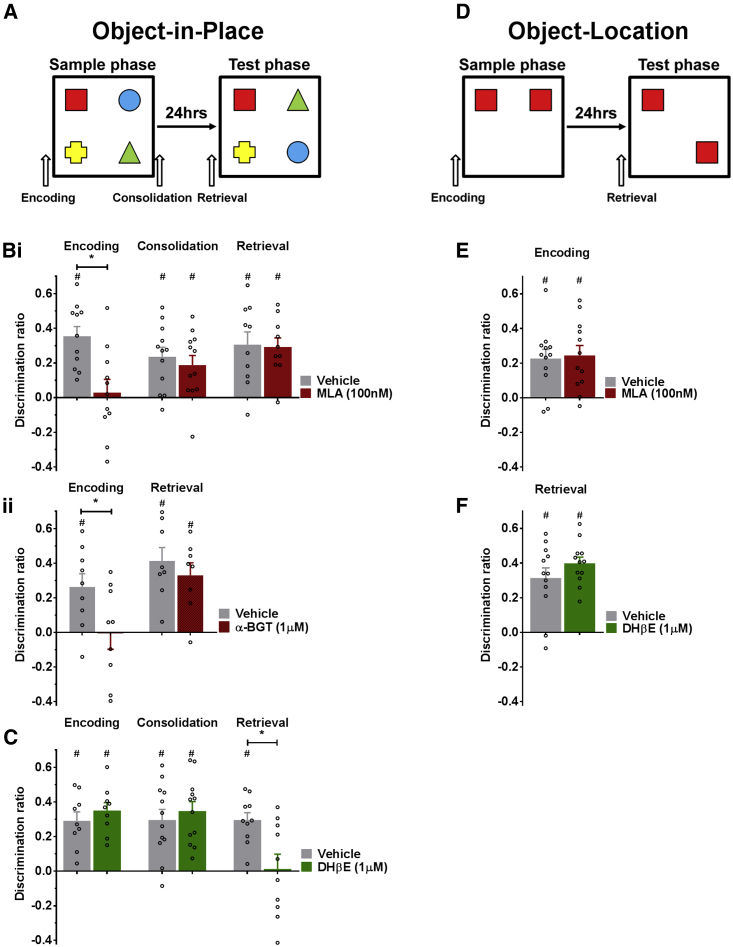
Associative Recognition Memory Is Dependent on Activation of Different nAChRs in the mPFC(A) Schematic of OiP task. Arrows represent the timing of mPFC infusions.(B) MLA impaired OiP memory when infused before the sample phase (encoding; n = 11), but not after the sample phase (consolidation; n = 12) or before the test phase (retrieval; n = 10) (i). α-BGT also impaired discrimination when infused before the sample phase (n = 9), but not before the test phase (n = 8) (ii).(C) DHβE impaired OiP memory if given before the test phase (n = 10), but not before (n = 9) or after (n = 12) the sample phase.(D) Schematic of the OL task(E and F) OL memory was not impaired by MLA infusion before the sample phase (n = 12) (E) or DHβE infusion before the test phase (n = 12) (F).Data are presented as mean ± SEM (∗p < 0.05 paired t test; #p < 0.05 one-sample t test against 0). See also Tables S1 and S2.